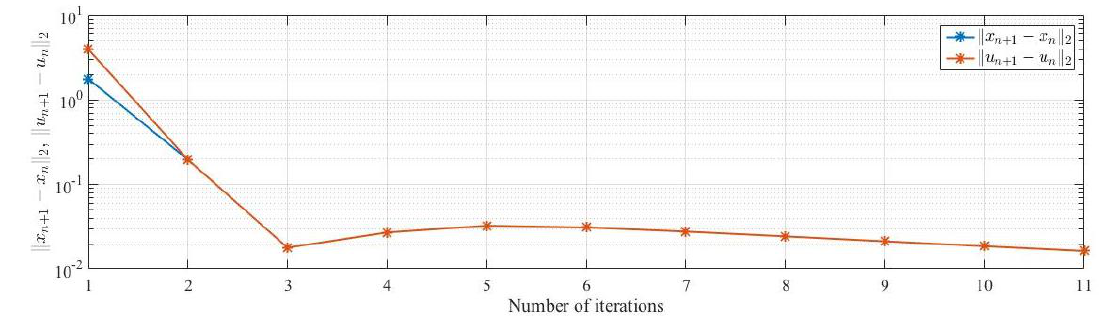
Figure 3. Example 1, case